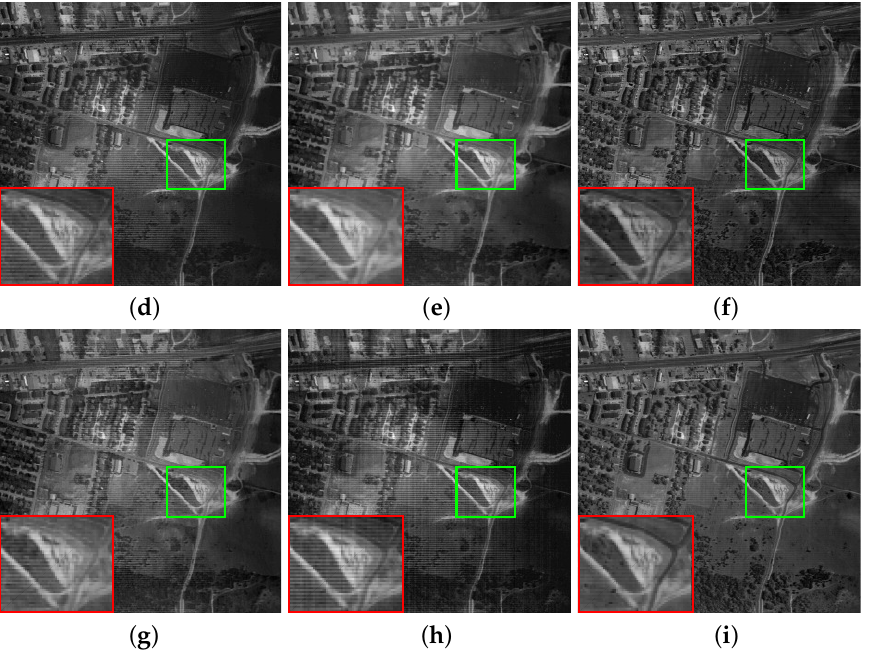
Figure 17. ( a ) Original image, image denoised by ( b ) LRTA, ( c ) BM4D, ( d ) LRMR, ( e ) LRTDTV, ( f ) L1HyMixDe, ( g ) LRTDGS, ( h ) 3DTNN, ( i ) ours of band 109 in dataset-4.